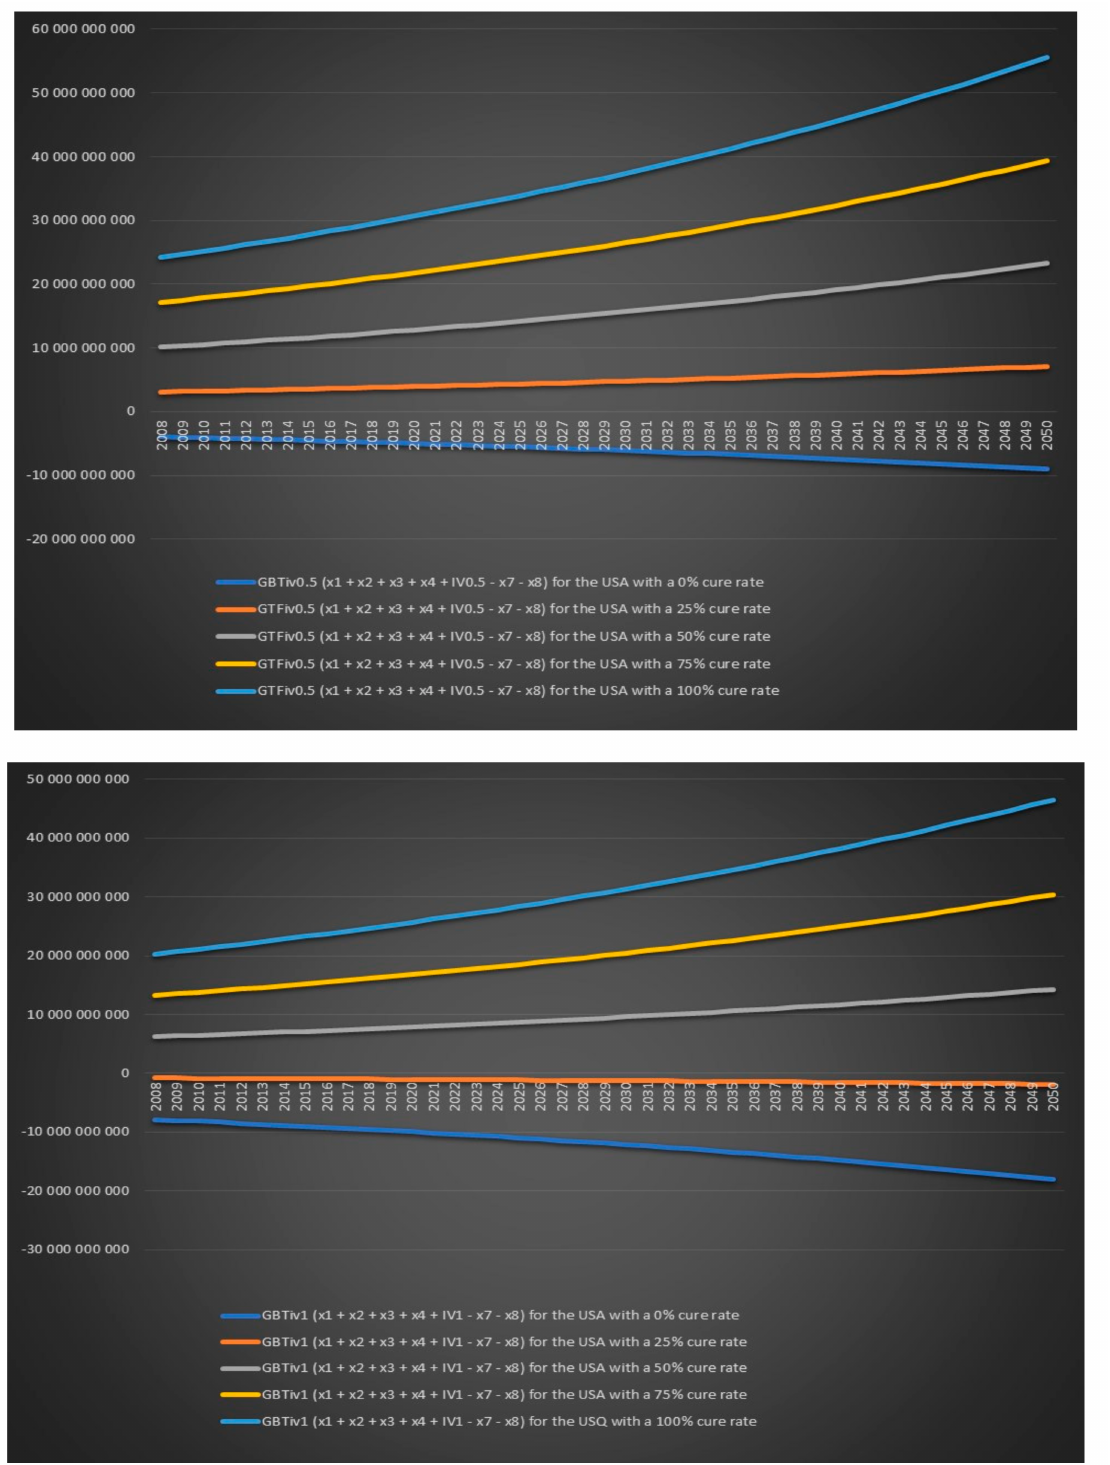
Figure 19. Today’s government costs and revenues in the USA over